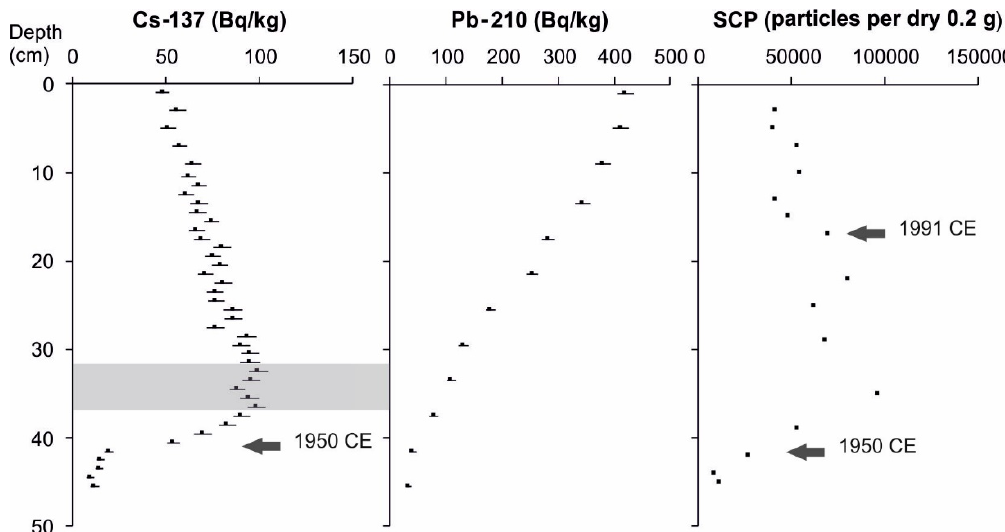
Figure 2. Downcore distribution of 137 Cs and 210 Pb activities as well as spheroidal carbonaceous particles (SCP) concentrations in the Lake Sekšu topmost sediments. The grey shaded area on the caesium diagram indicates time period 1956–1965 CE.